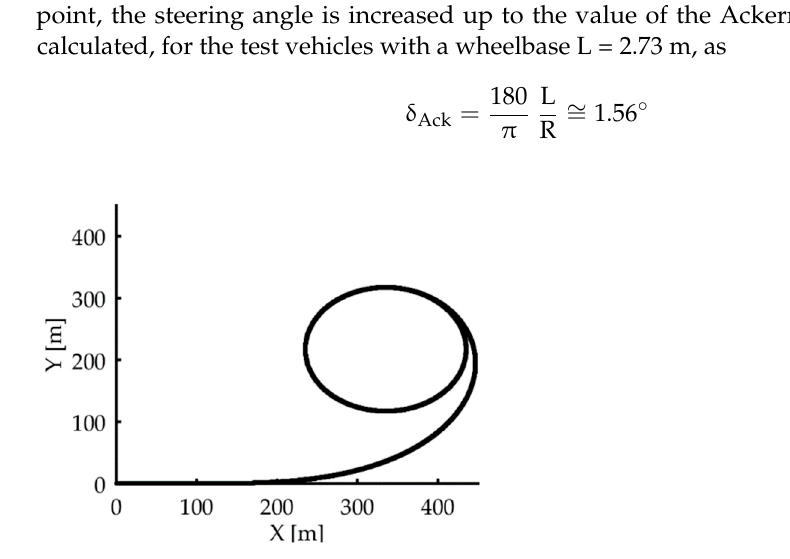
Figure 3. Constant radius test trajectory.